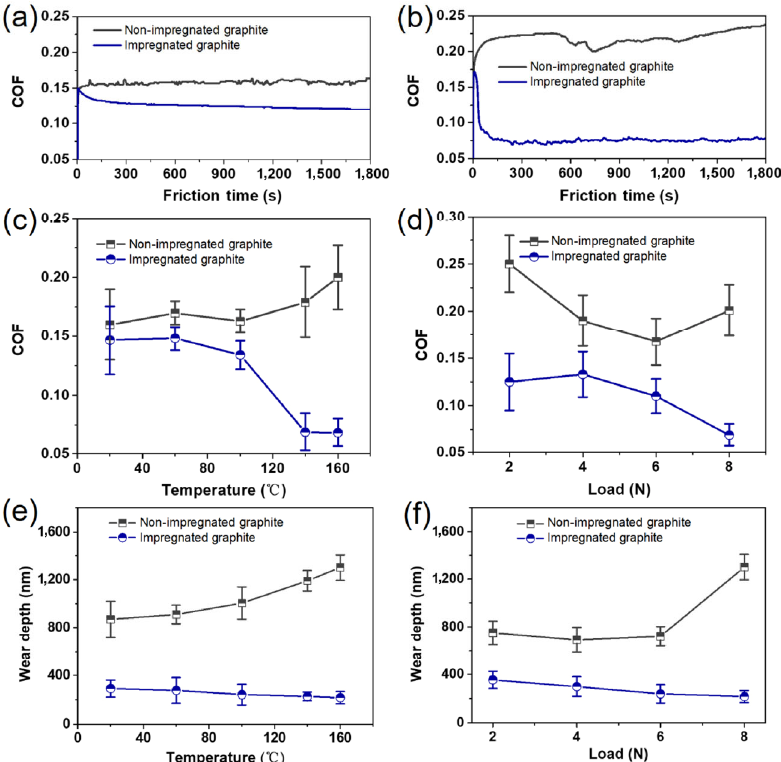
Fig. 3 COFs of impregnated graphite and non-impregnated graphite at the temperatures of 20 °C (a) and 160 °C (b), and COFs as a function of temperature under a load of 8 N (c). COFs as a function of load at 160 °C (d). Anti-wear properties of impregnated graphite and non-impregnated graphite at different temperatures under a load of 8 N (e). Comparison of the anti-wear properties at 160 °C under different loads